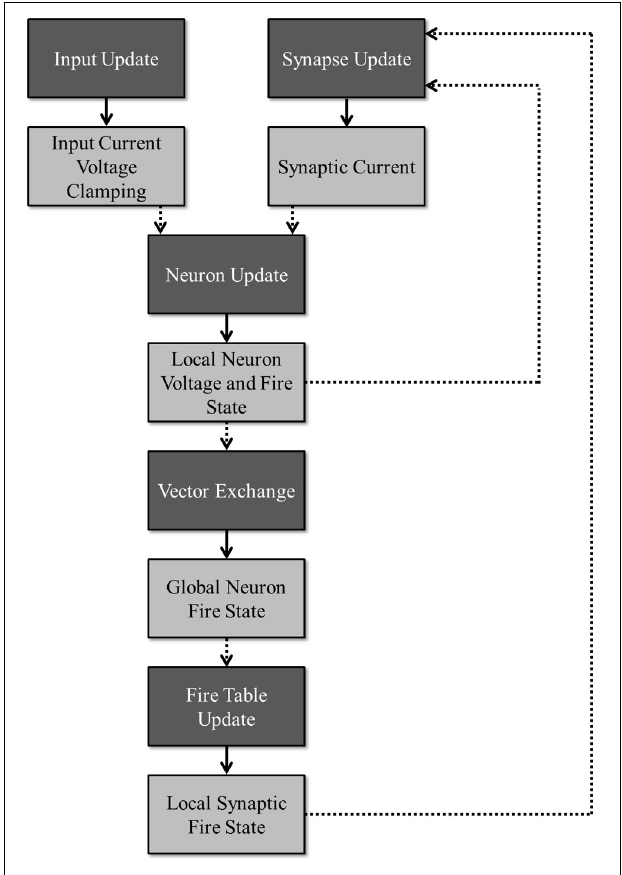
FIGURE 2 | Division of work: the dark boxes represent stages that can run concurrently as long as the necessary data has been received for a given time step. Each stage produces an output (denoted by the lighter boxes) that is consumed by the stage denoted by the dotted